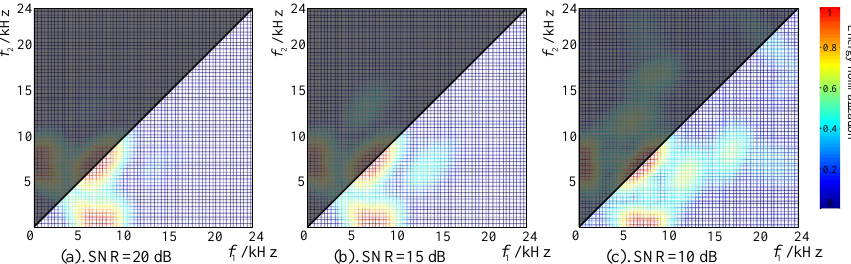
Figure 5. Comparison of higher-order spectrum under different SNRs.